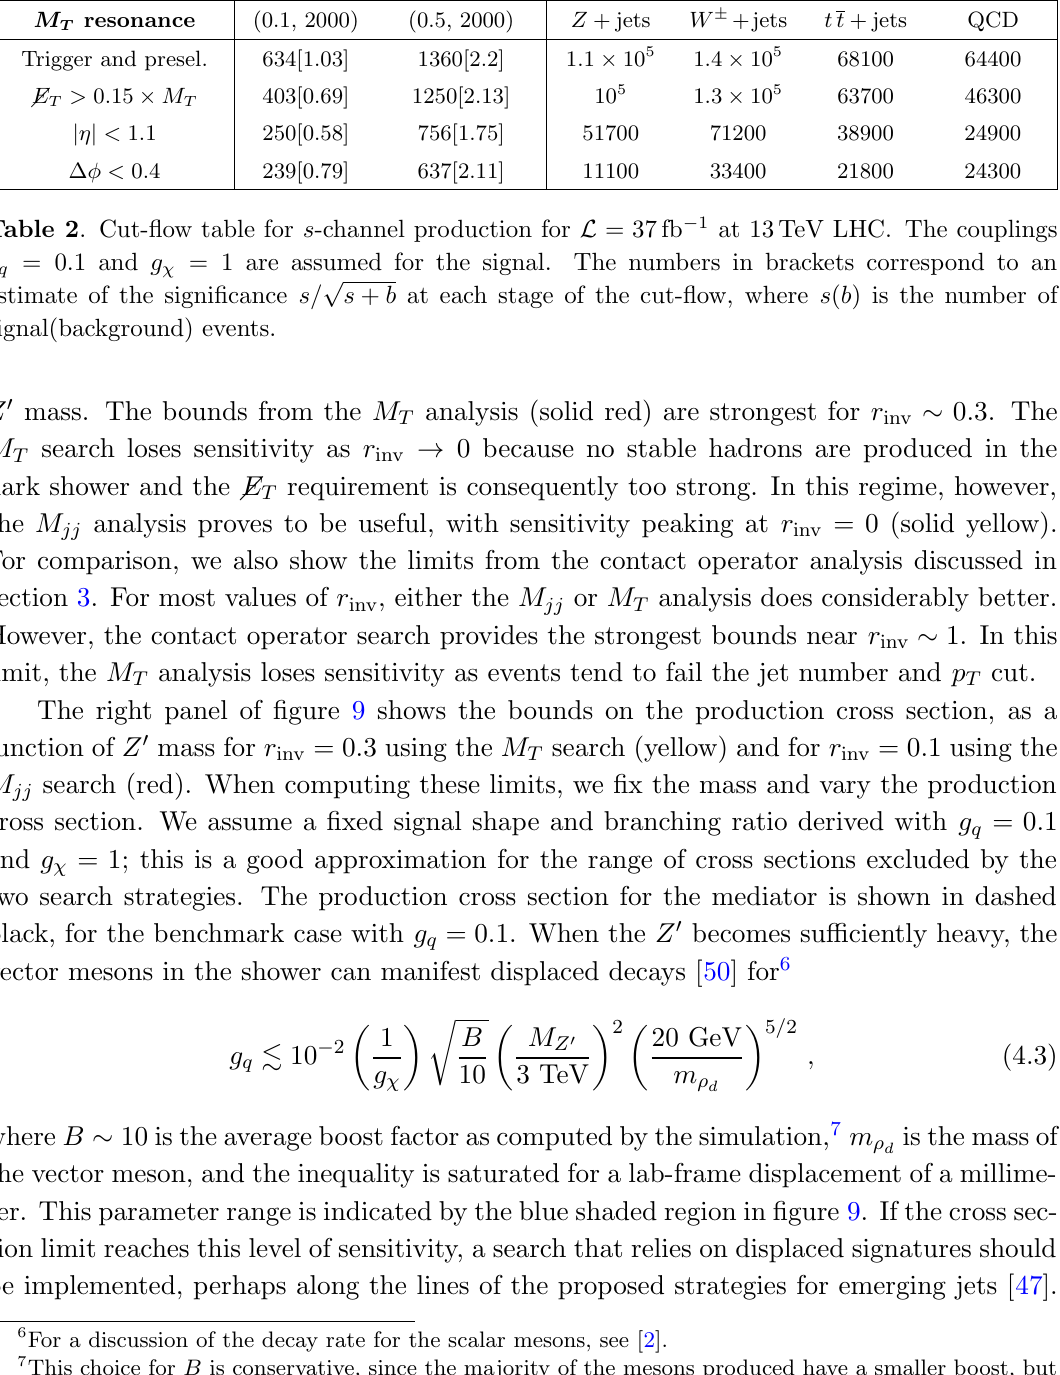
= 37 fb (cid:0) 1 at 13 TeV LHC. The couplings L